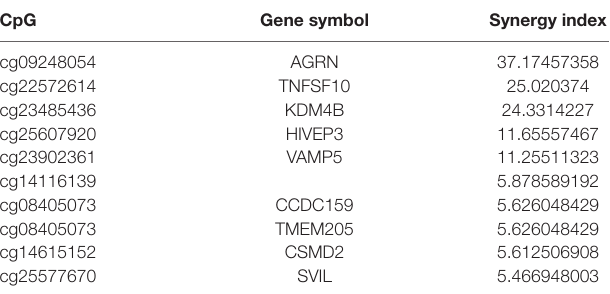
TABLE 5 | List of the top 10 synergy sites.